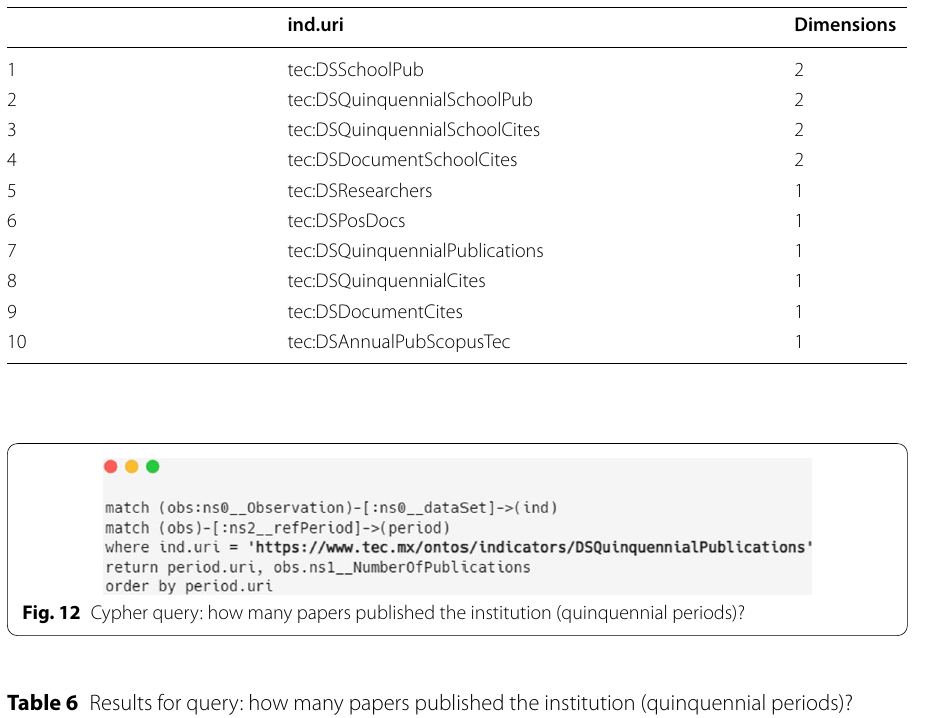
Table 6 Results for query: how many papers published the institution (quinquennial periods)? period.uri